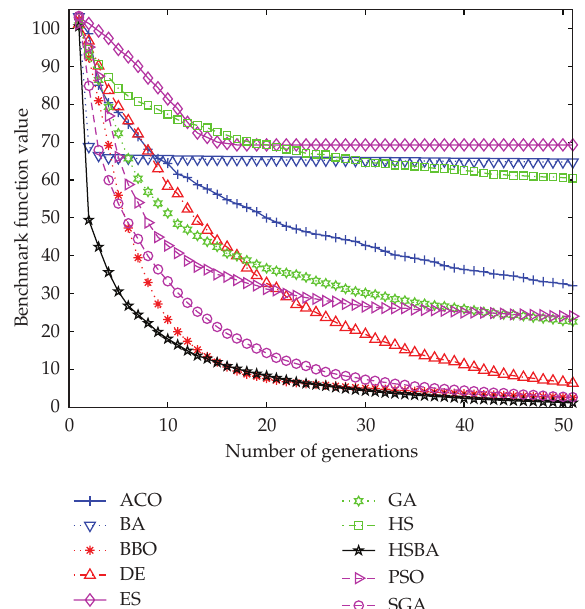
Figure 13: Comparison of the performance of the different methods for the F13 Sphere function.